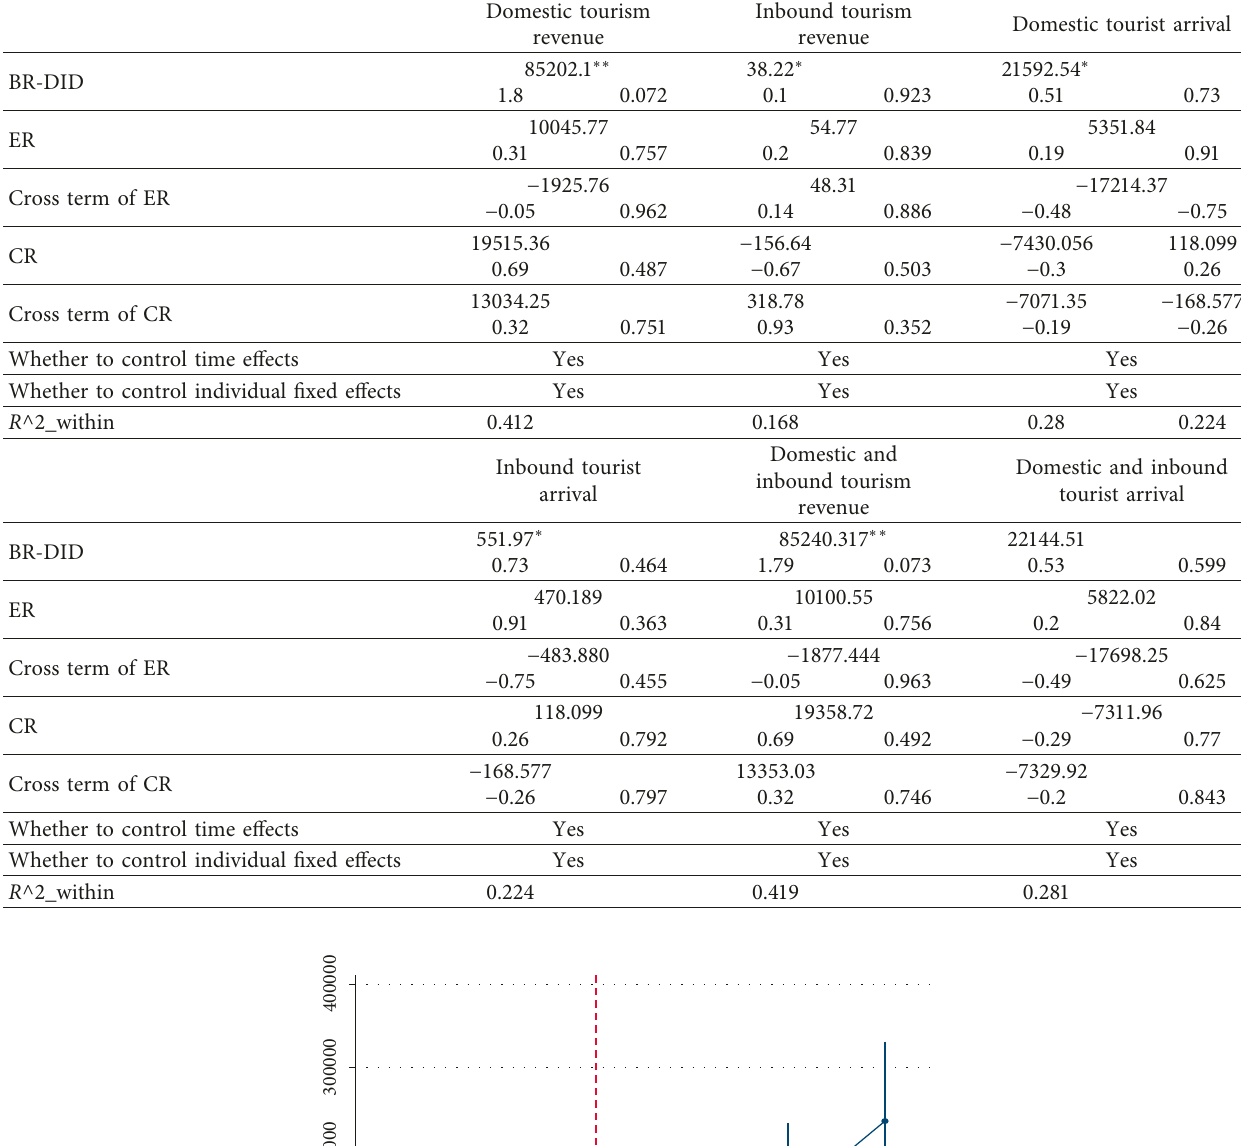
Table 4: Impact of the Belt and Road on tourism along the policy route after the inclusion of territorial control.